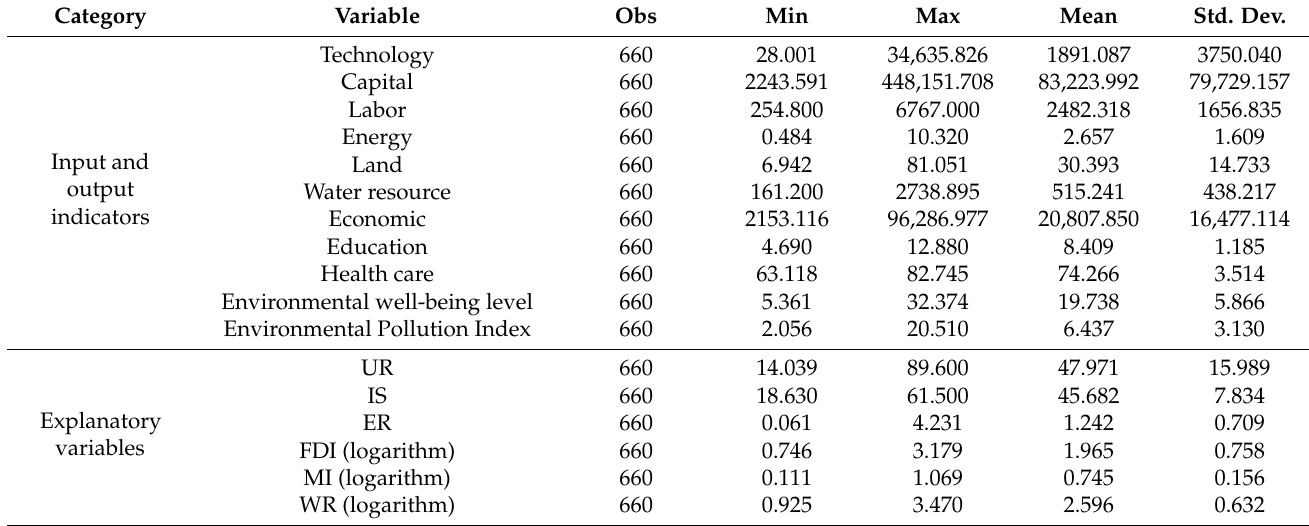
Table 4. Descriptive statistics of input and output indicators and explanatory variables.